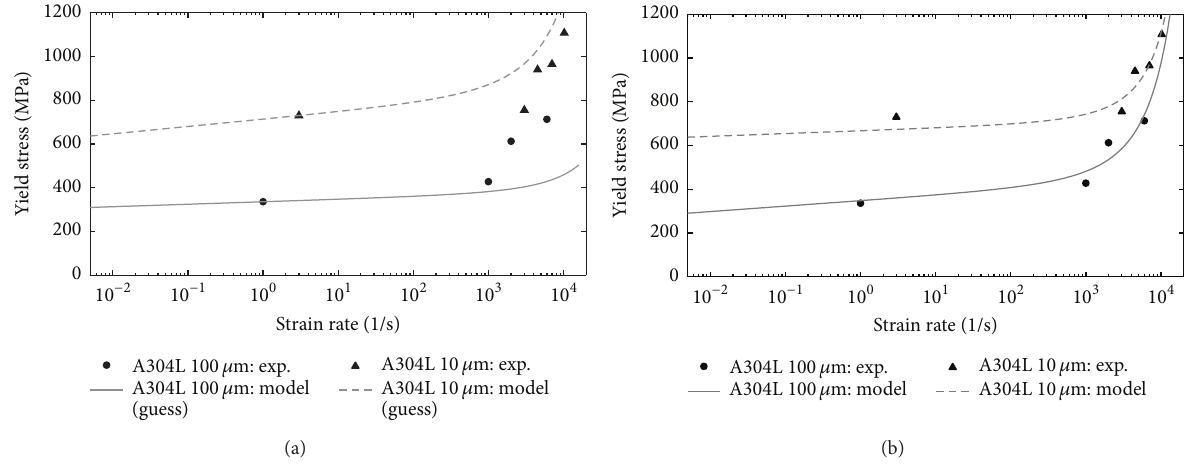
Figure 2: Comparison between experimental data (Couque [4]) and new modified Eyring equation for steel: (a) first-guess material constants and (b) optimized materials constants.